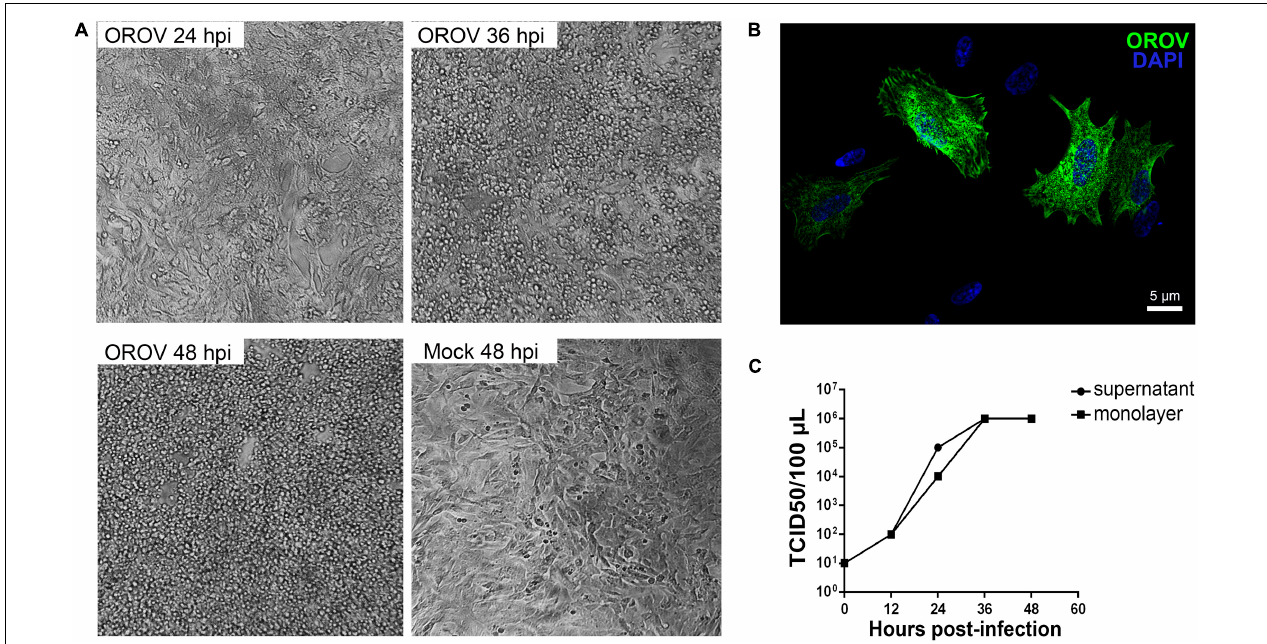
FIGURE 4 | Differentiated human neuroblastoma cells support OROV replication. Neuroblastoma SH-SY5Y cells were differentiated into mature neurons and inoculated with OROV. (A) Cytopathic effect in SH-SY5Y cells was observed 24, 36, and 48 hpi. Images were obtained using the 20 × objective. (B) Representative immunofluorescence labeling of OROV antigen (green) in SH-SY5Y cells exposed to OROV. (C) Virus titers in supernatants and monolayer at different times post infection of cultures of SH-SY5Y cell line ( n = 3 biological